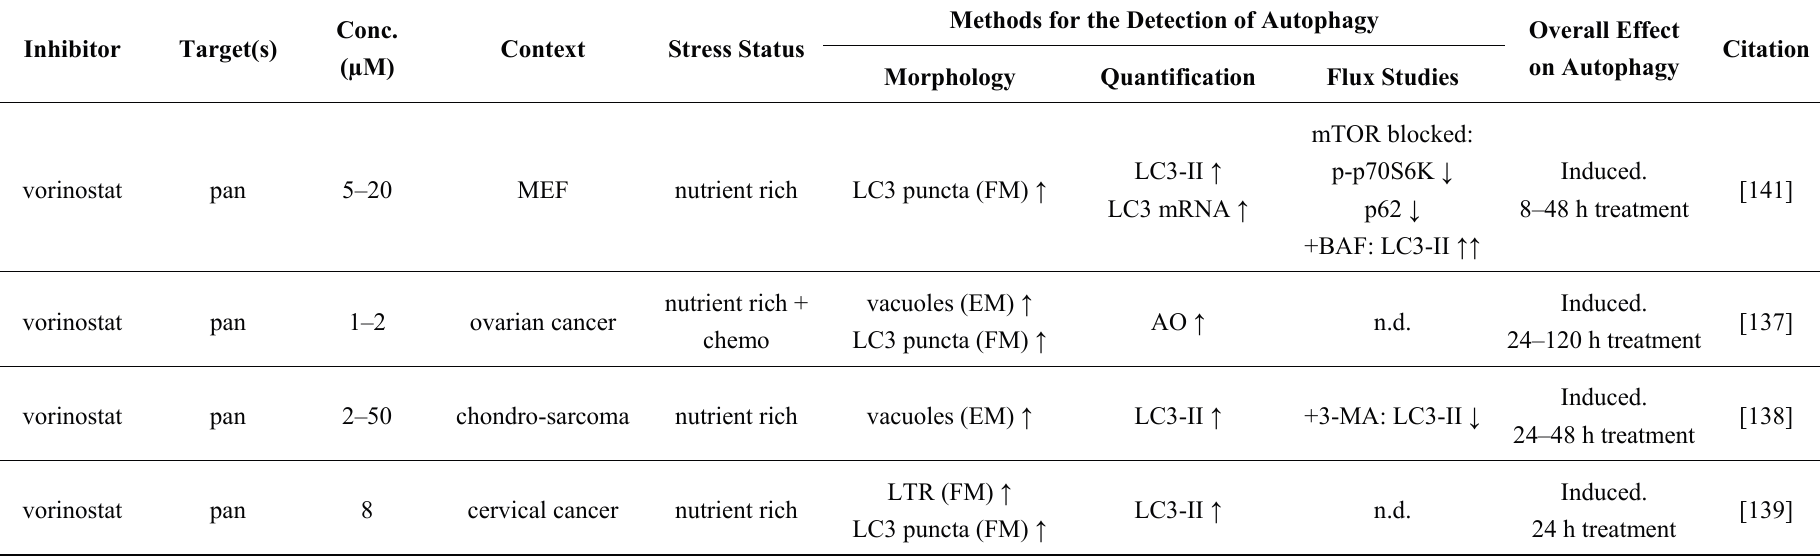
Table 3. Selected recent publications using HDACi in cancer treatment to augment autophagy. MEF—murine embryonic fibroblast; FM—fluorescent microscopy; mTOR—mammalian target of rapamycin; BAF—bafilomycin A1; chemo—chemotherapy: decitabine (DNA methyltransferase inhibitor); EM—electron microscopy; AO—acridine orange, acidotropic dye, stains late-stage